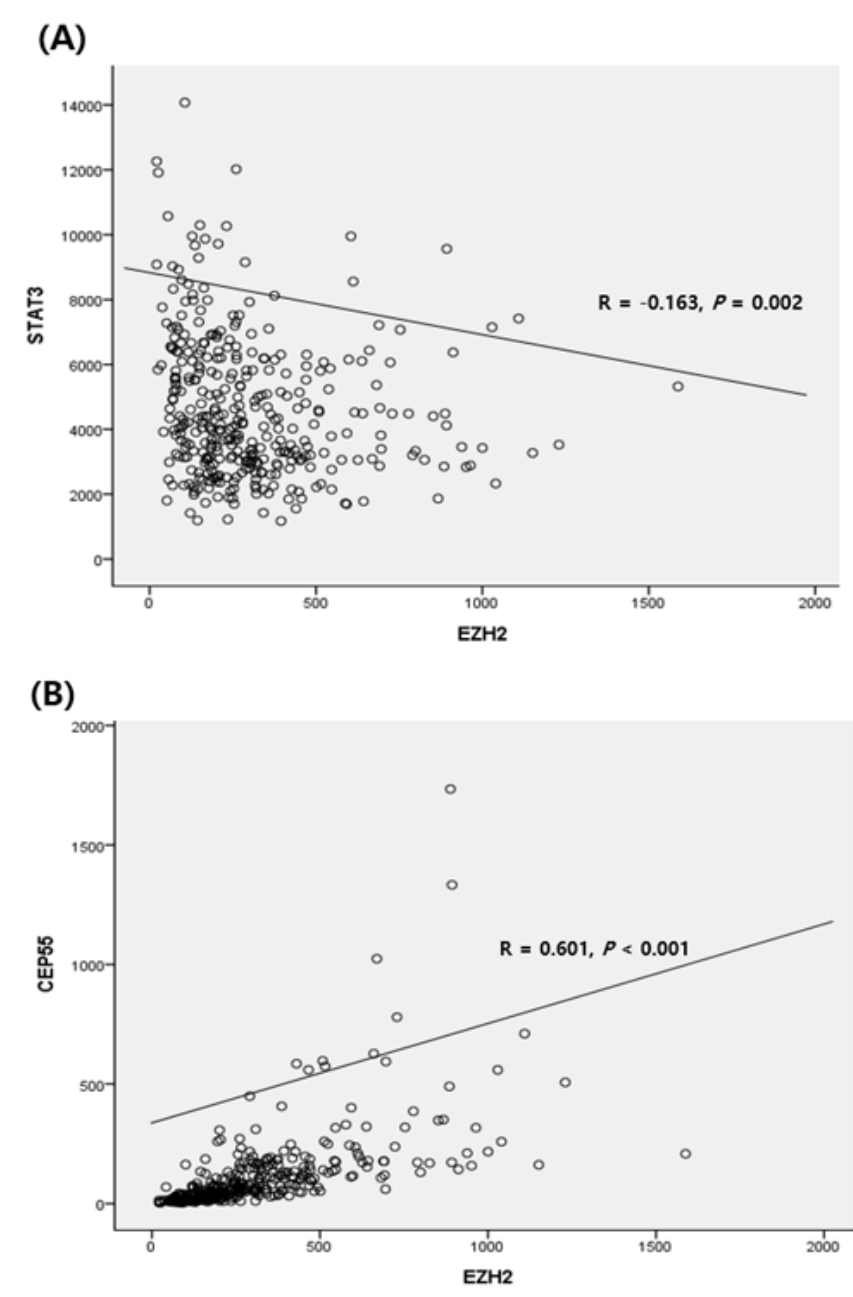
Figure 2. Correlation analysis: ( A ) between EZH2 STAT3 and ( B ) between EZH2 expression and CEP55.